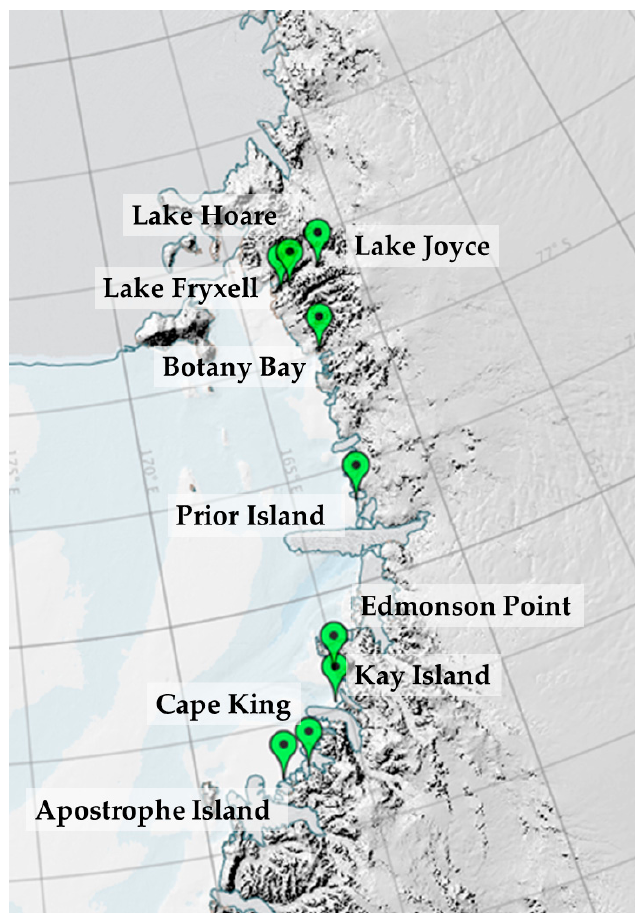
Figure 1. Map of sampling localities.